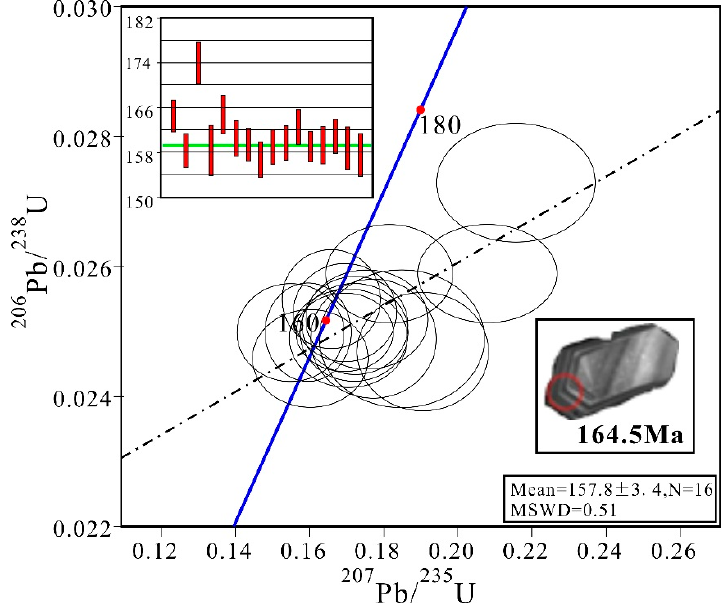
Figure 10. 206 Pb/ 238 U versus 207 Pb/ 235 U diagrams for the Xiajinbao granite.